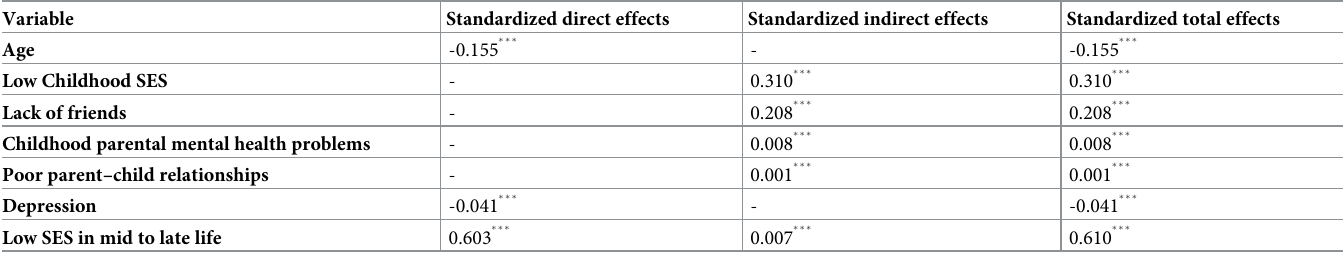
Table 3. The standardized direct effects, indirect and total effects of the childhood adversities on cognitive function in mid to late life ( N = 9 , 942 ).